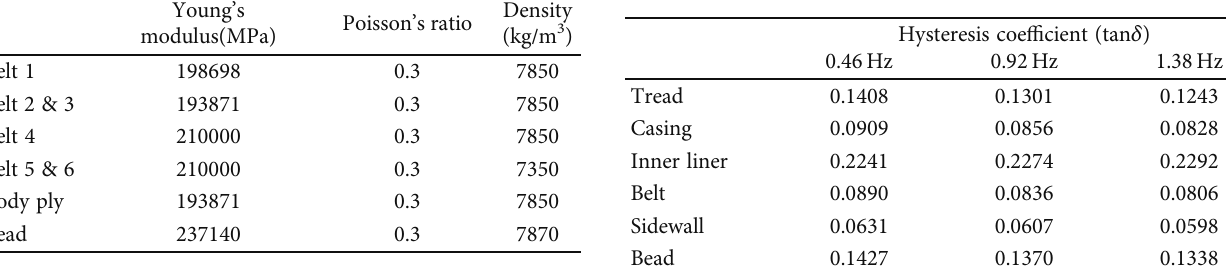
Table 4: Average hysteresis coe ffi cients of compounds measured through testing.